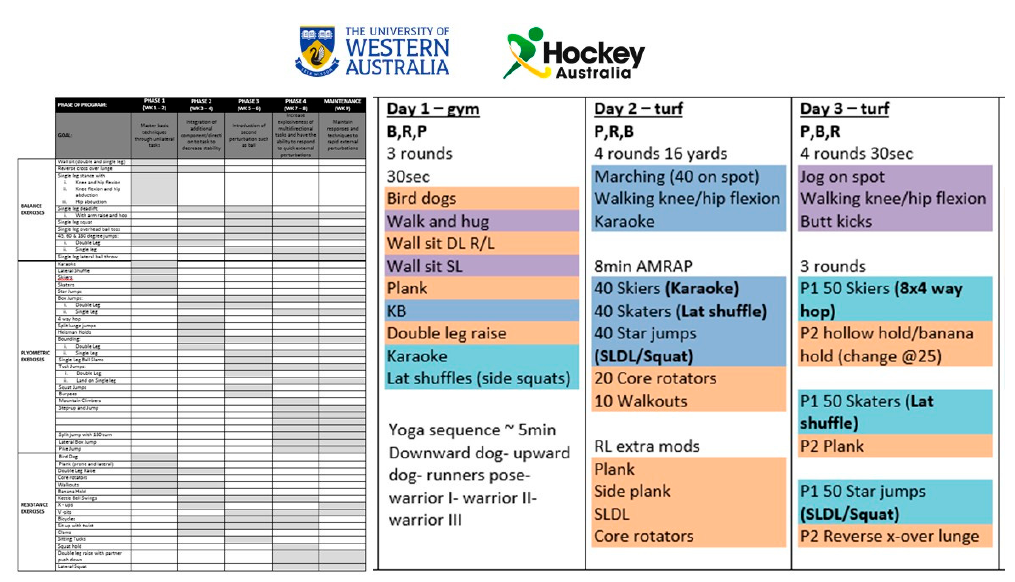
Figure 6. Example training program and schedule developed by The University of Western Australia in collaboration with Hockey Australia.